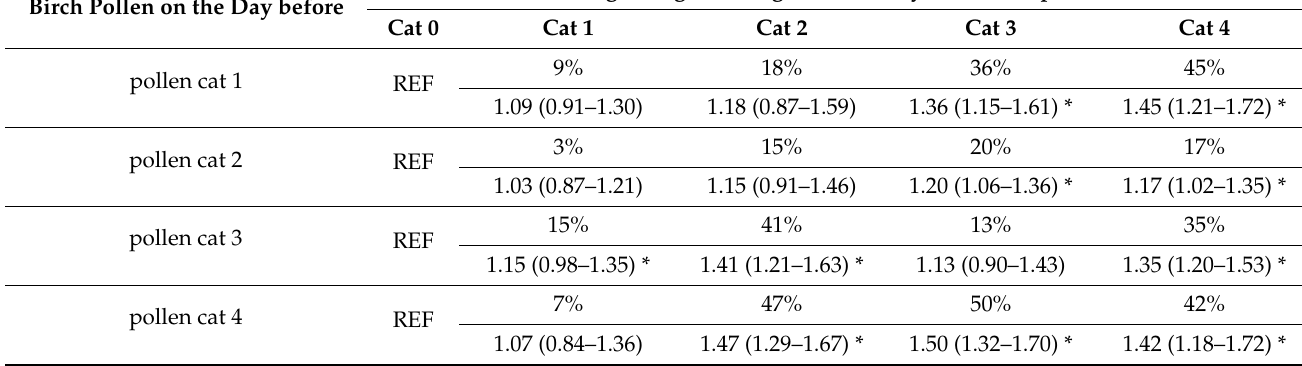
Table 5. The changes (%) in the number of daily outpatient visits due to respiratory causes related to the birch pollen concentrations (pollen grains/m 3 /day; in five categories) and the number of lightning discharges per day (in five categories) on the day before. The post-estimation β coefficient values, including the confidence interval (CI) values at the 95% significance level, are depicted below the change estimates (%). Significant results are marked with *. Adjustment for the season time was performed using dummy